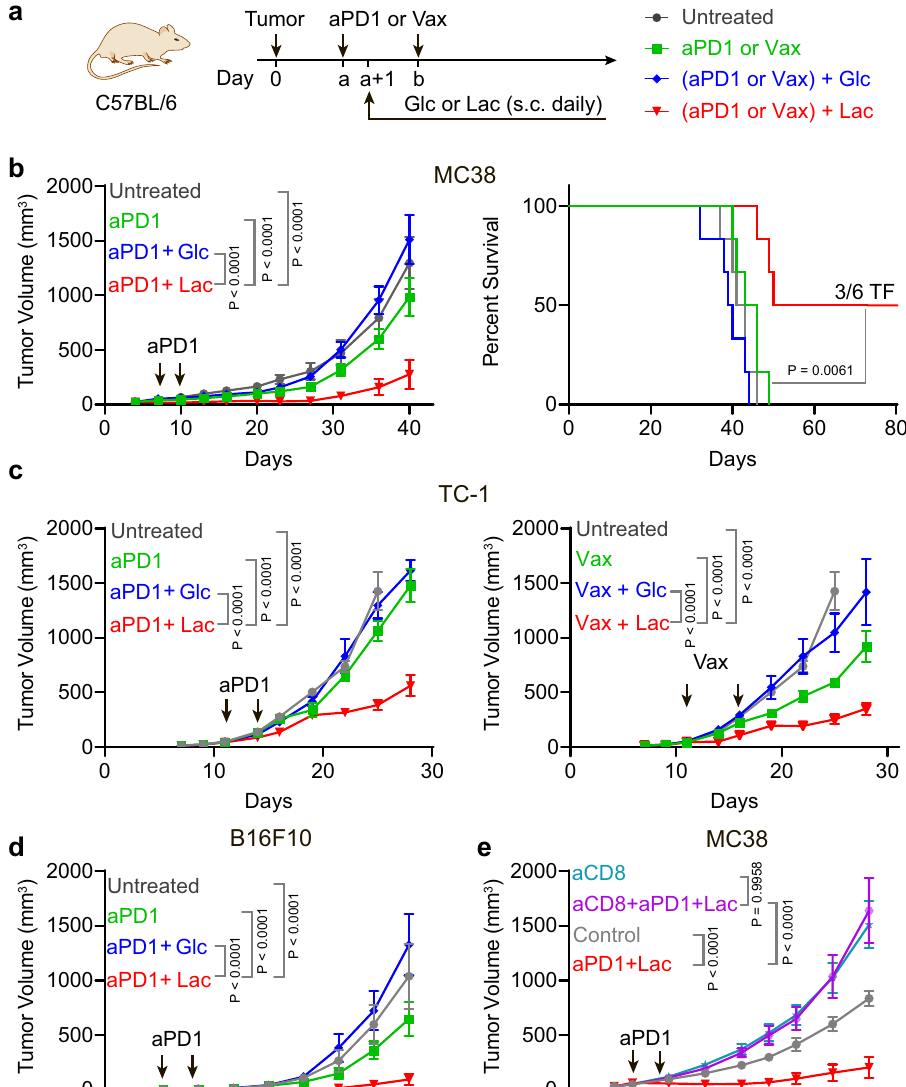
Fig. 2 | Lactate but not glucose promotes antitumor immunity in multiple tumor models. a Treatment regimen for immunotherapy in combination with glucose (Glc) or lactate (Lac). Glucose (5g/kg) or lactate (1.68g/kg) was admini- strated subcutaneously daily one day after the fi rst dose of anti-PD-1 (aPD1, i.p. injection) or PC7A vaccine (Vax, s.c. injection) treatment. b Tumor growth and survivaldataofanti-PD-1combinedwithglucoseorlactateinMC38tumormodel. C57BL/6 mice ( n =6) were inoculated with 1×10 6 MC38 tumor cells and treated withanti-PD-1(10mg/kg,day7and10)incombinationwithglucoseorlactate.TF: tumor free. c Tumor growth curves of anti-PD-1 or PC7A vaccine combined with lactateorglucoseinTC-1tumormodel.C57BL/6mice( n =6)wereinoculatedwith 1.5×10 5 TC-1 tumor cells and treated with anti-PD-1 (10mg/kg, day 11 and 14) or PC7A vaccine (0.5 μ g E7 peptide, day 11, 16) in combination with glucose or